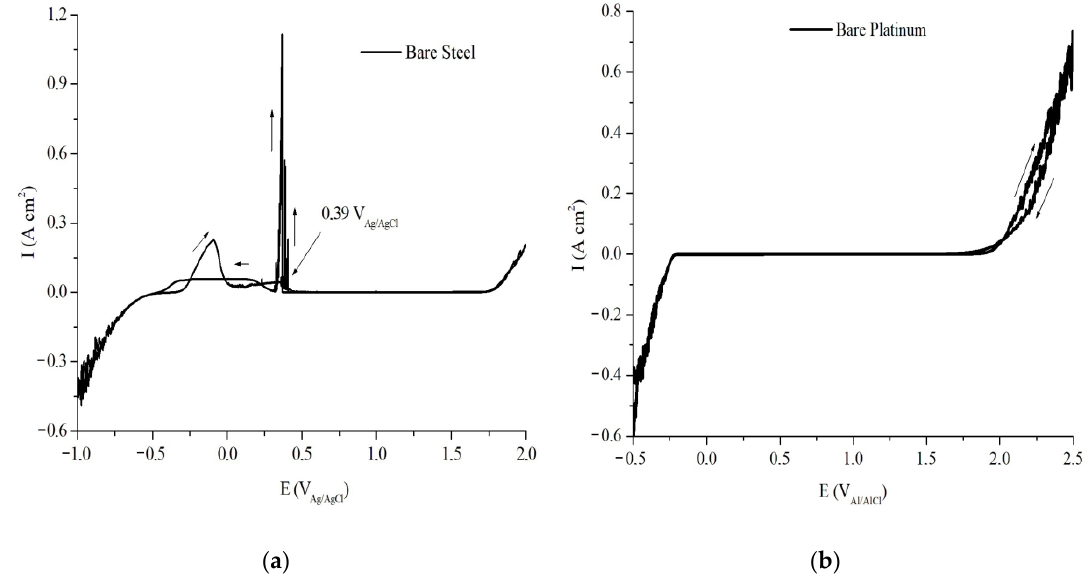
Figure 6. Voltammograms of ( a ) uncoated AISI 1010 steel, between −1.00 to +2.00 V Ag/AgCl ; and ( b ) uncoated Pt, between −0.50 to +2.50 V Ag/AgCl , in solution 2 mol L −1 of H 2 SO 4 aqueous solution.